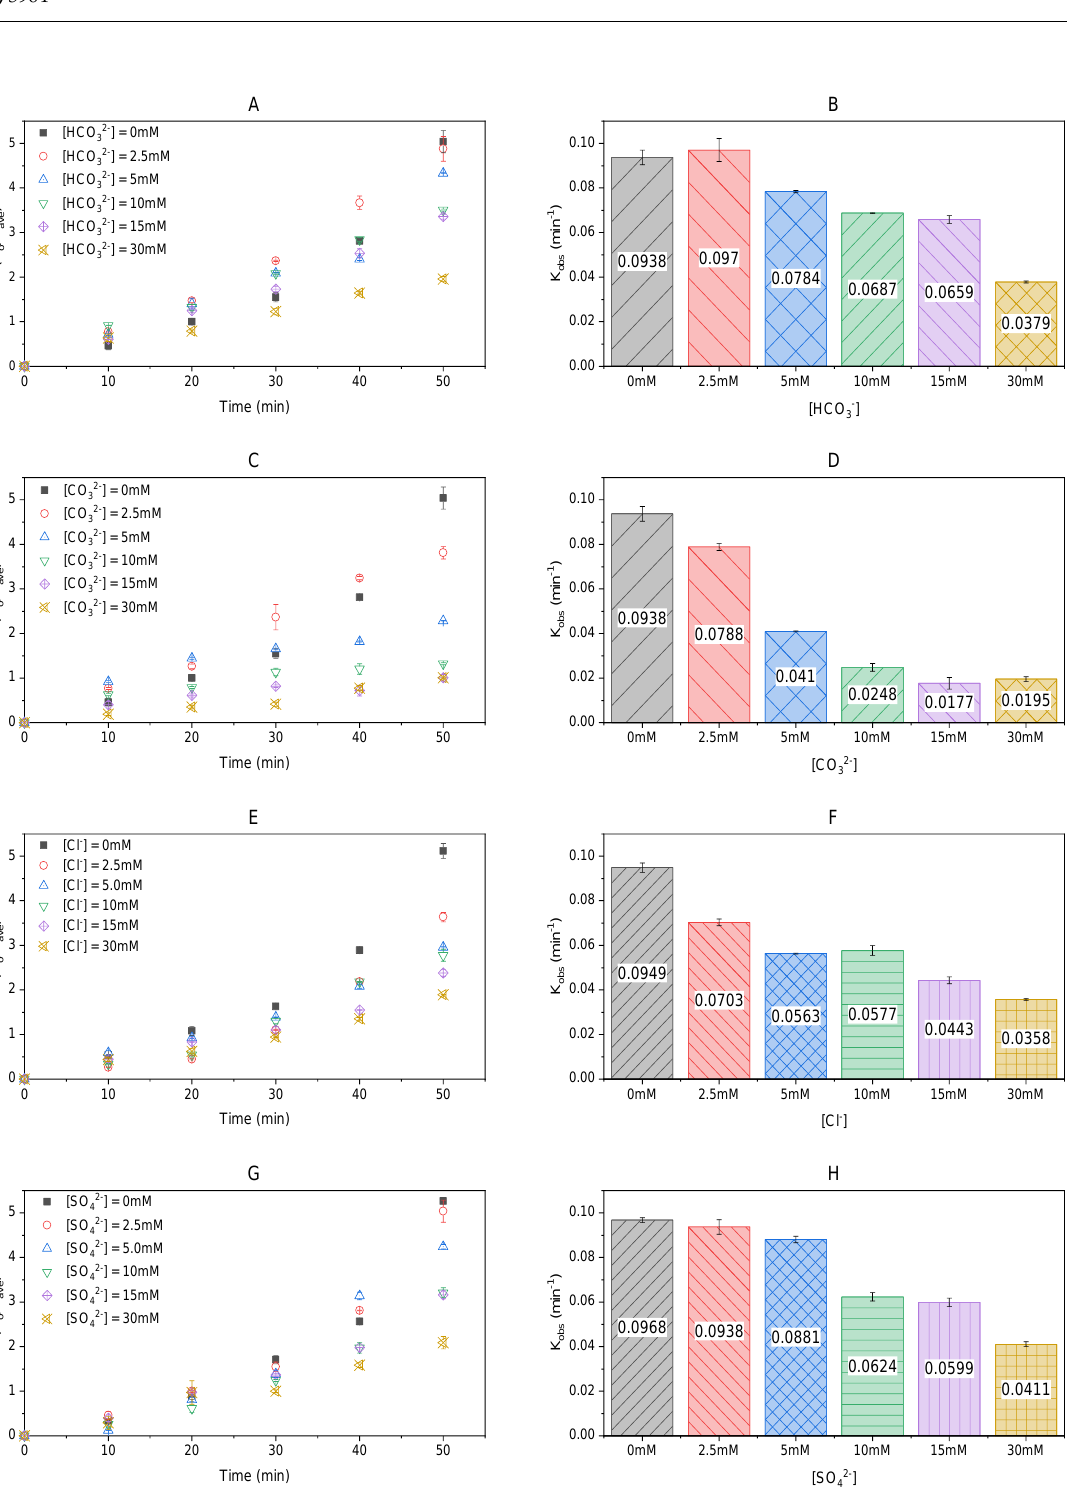
Figure 10. ( A ) ln (C o /C ave ) against time and ( B ) k obs , min −1 for varied [HCO 3 − ] conditions; ( C ) ln (C o /C ave ) against time and ( D ) k obs , min − 1 for varied [CO 32 − ] conditions; ( E ) ln (C o /C ave ) against time and ( F ) k obs , min − 1 for varied [Cl − ] conditions; and ( G ) ln (C o /C ave ) against time and ( H ) k obs , min − 1 for varied [SO 4 2 − ]